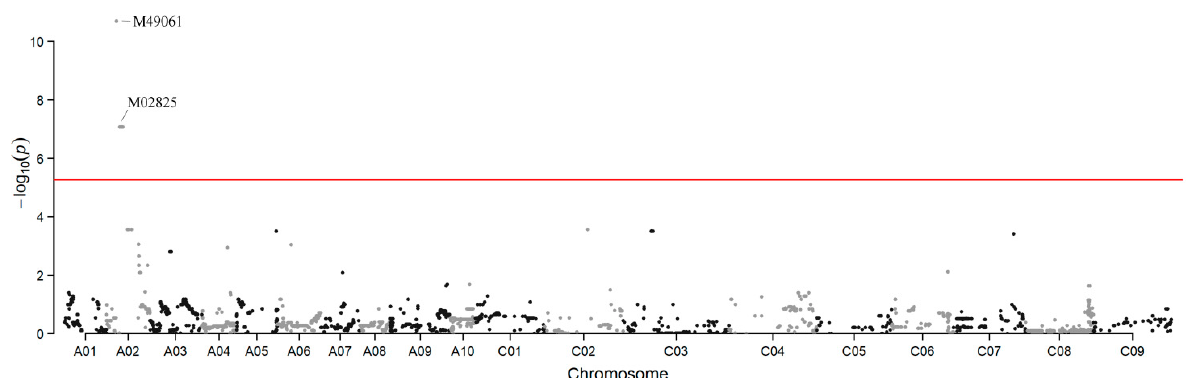
Figure 2. Manhattan plots of association analysis. Each dot represents an SNP. The horizontal red line represents the Bonferroni-corrected significance threshold − log10 ( p ) = 5.27. Table 4. Contingency table of the two SNP markers vs leaf up-curling trait in BC 1 of ZS11 ×